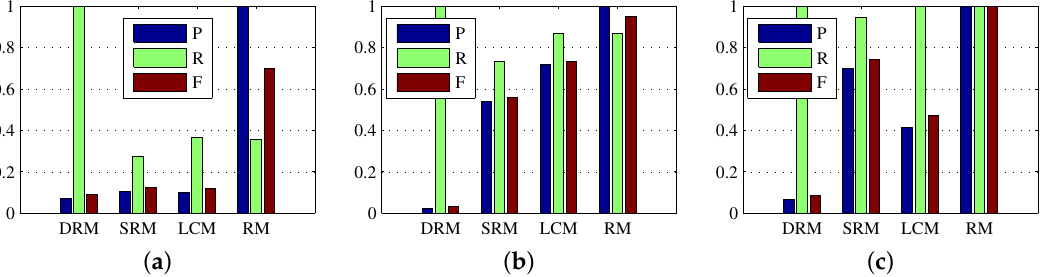
Figure 3. Precision, recall, and F-measure bars for the procedures of the proposed method. ( a – c ) denote the results of the procedures of the proposed method on Sequence 1, Sequences 2 and Sequence 3 respectively.